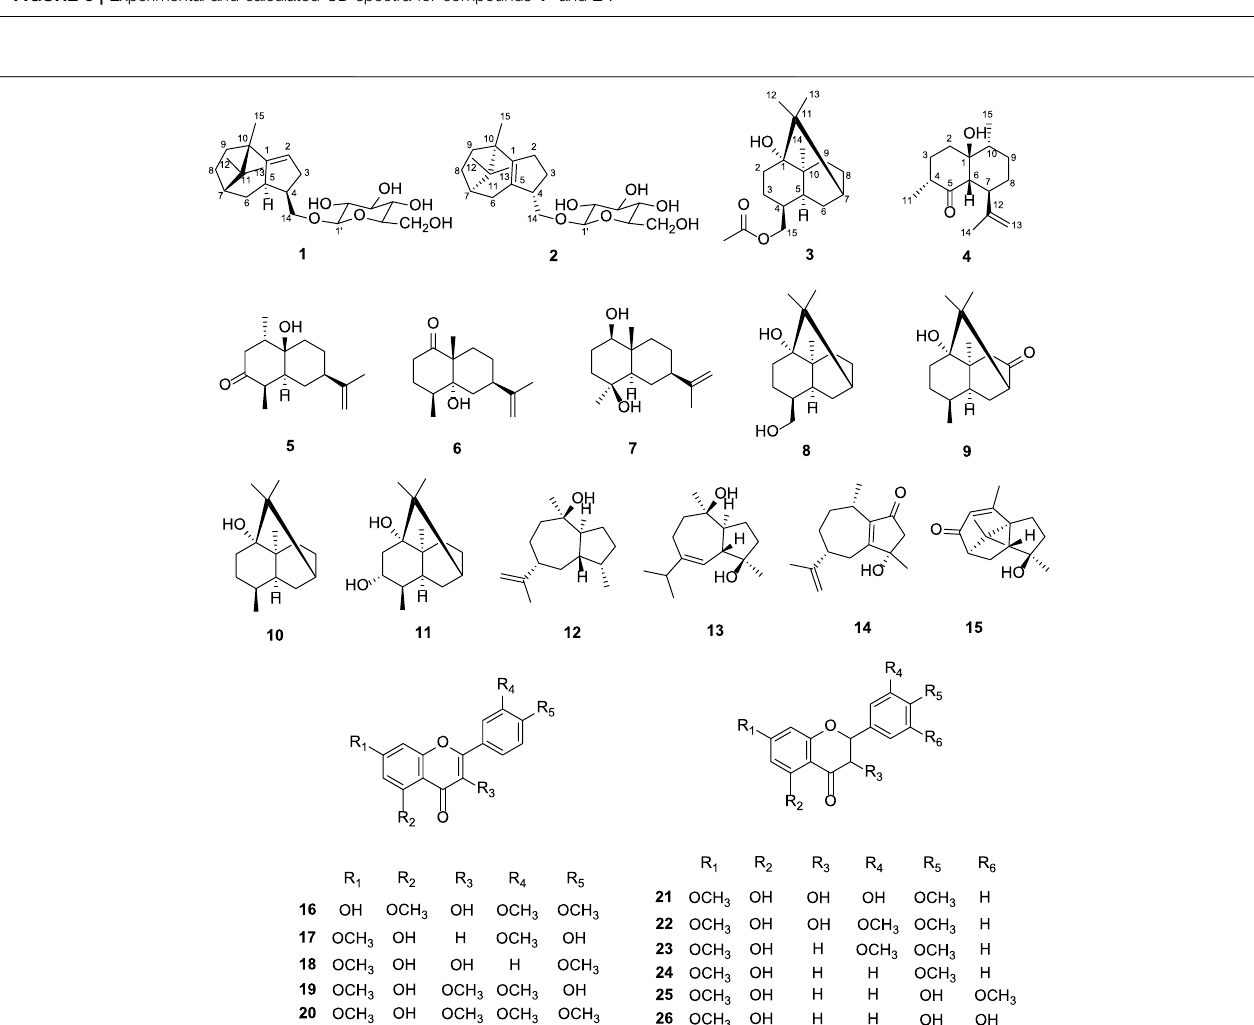
FIGURE 3 | Experimental and calculated CD spectra for compounds 1 9 and 2 9 .